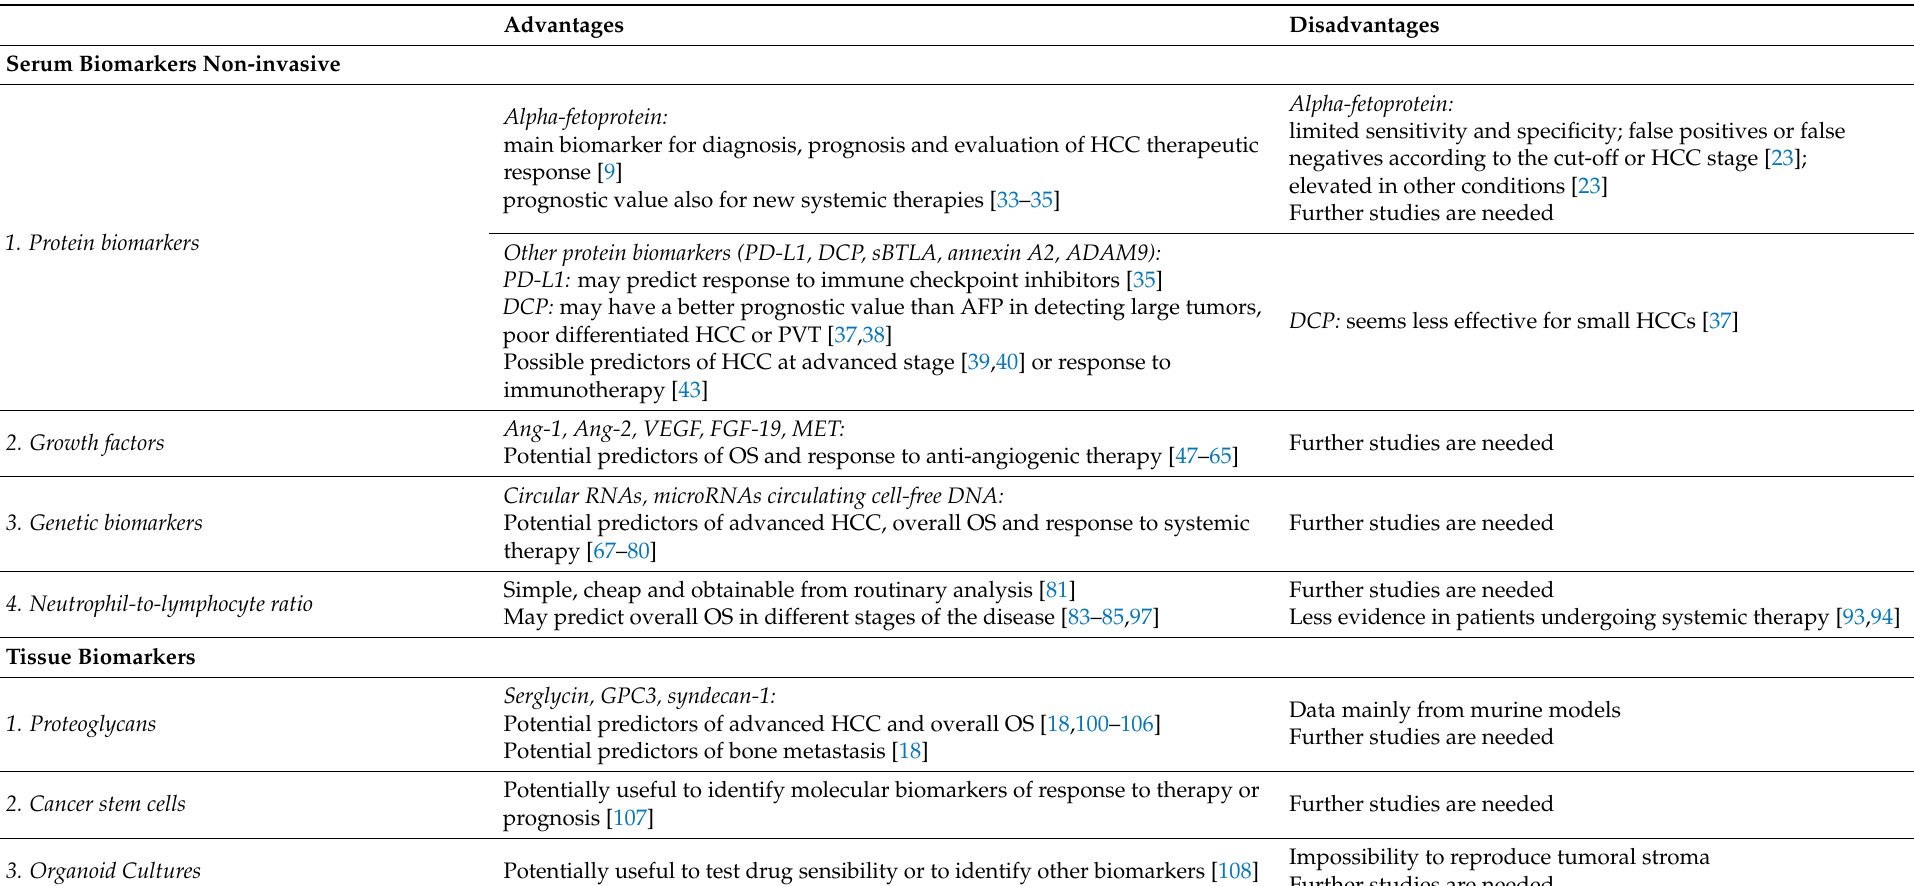
Table 2. The advantages and disadvantages of the principal biomarkers applied in the management of hepatocellular